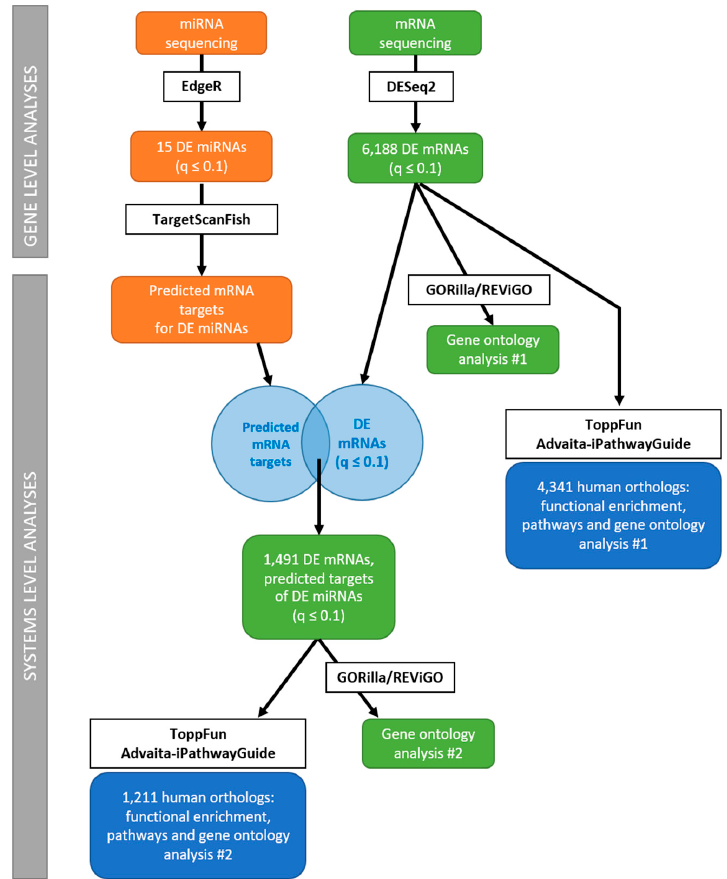
Figure 1. Workflow for analysis of mRNA ‐ Seq and miRNA ‐ Seq data at the gene and systems level.